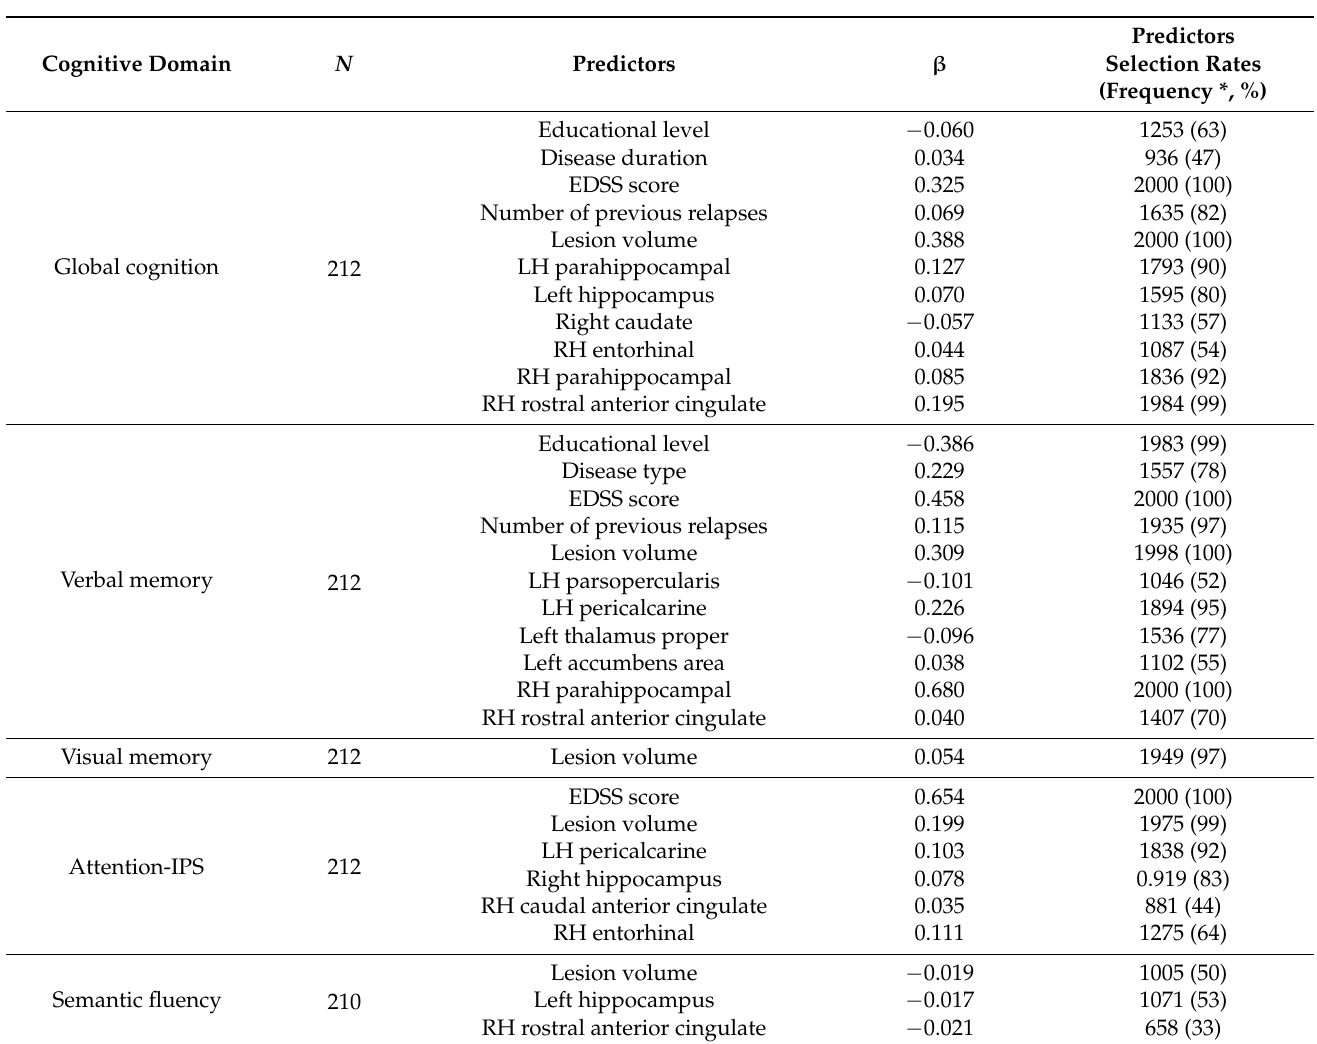
Table 3. Predictors of each Lasso regression